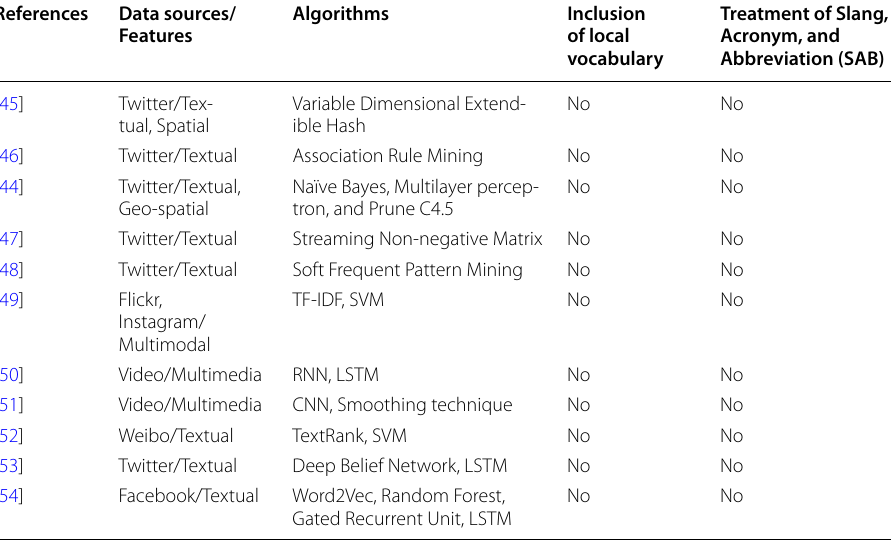
Table 3 Supervised learning approaches used for event